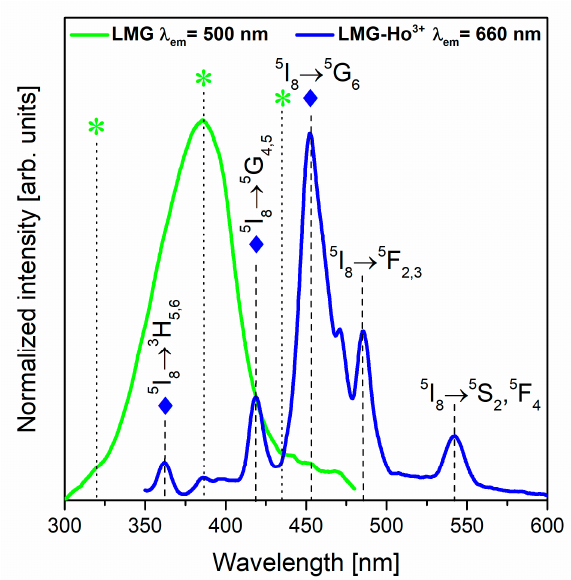
Figure 7. Excitation spectra of LMG and LMG-Ho 3+ ceramics.